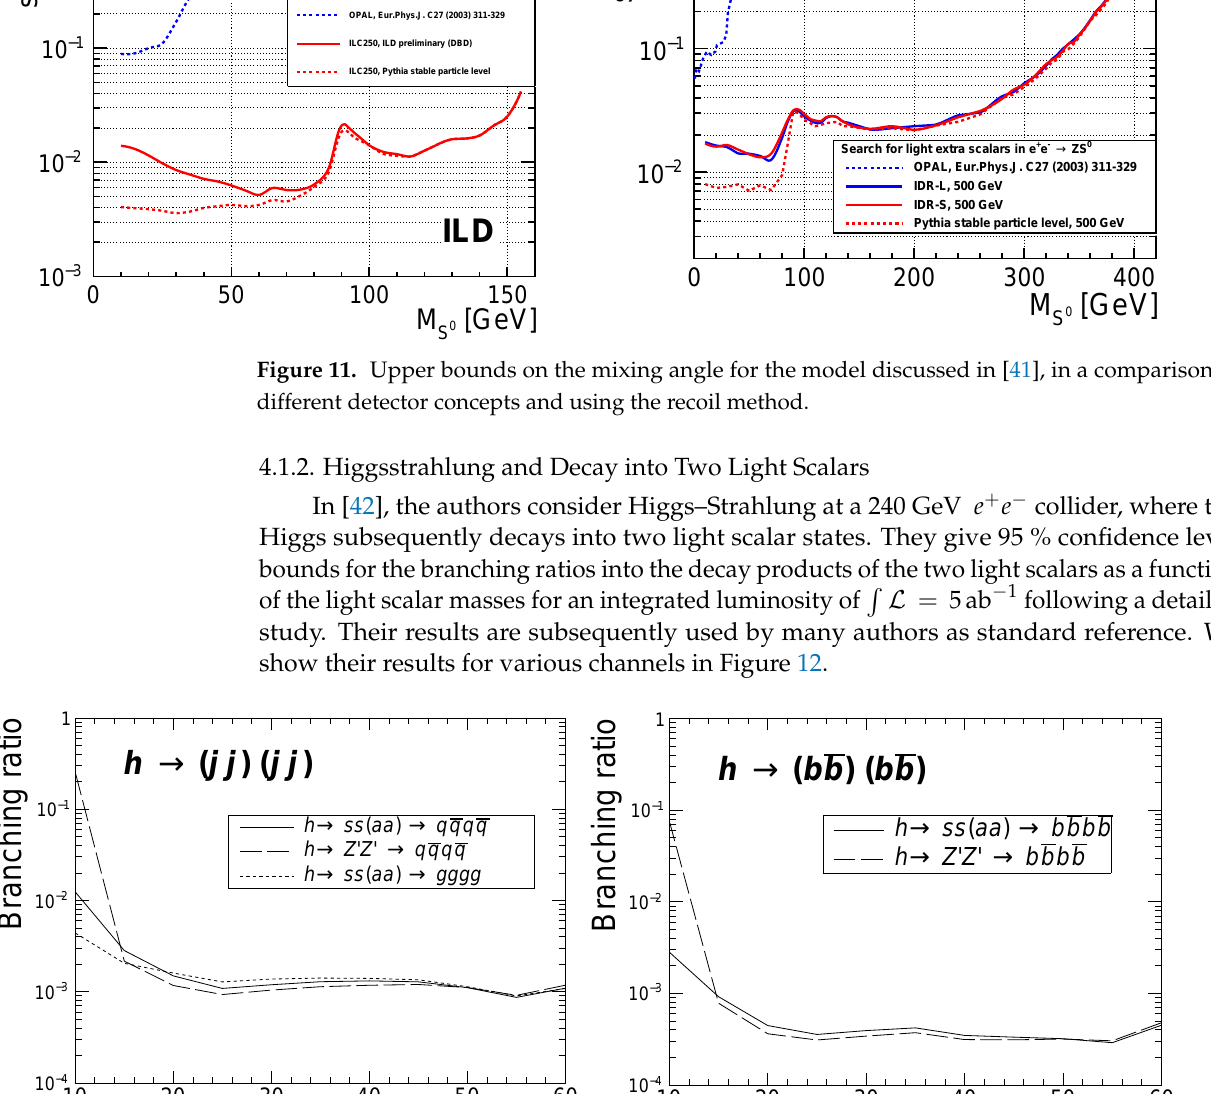
(cid:82) = 5ab − 1 . Taken from [42]. L